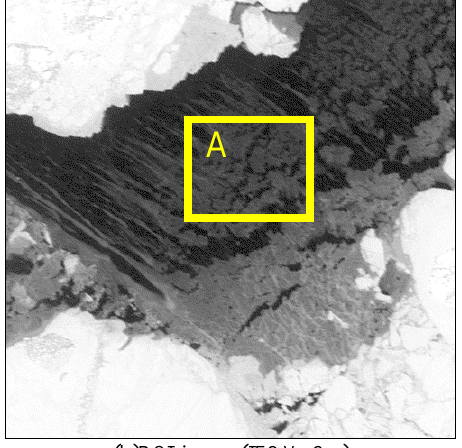
Figure 4. Comparison of MODIS image and RSI image (The Sea of Okhotsk, February 9, 2012)